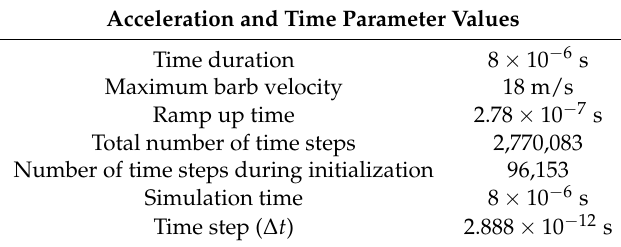
Table 3. Typical values for parameters relating to acceleration of the barb and time